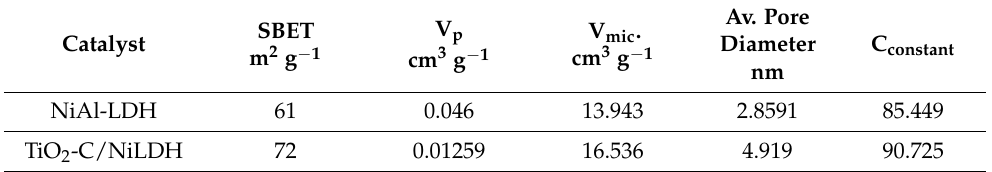
Table 2. The textural properties for all the investigated